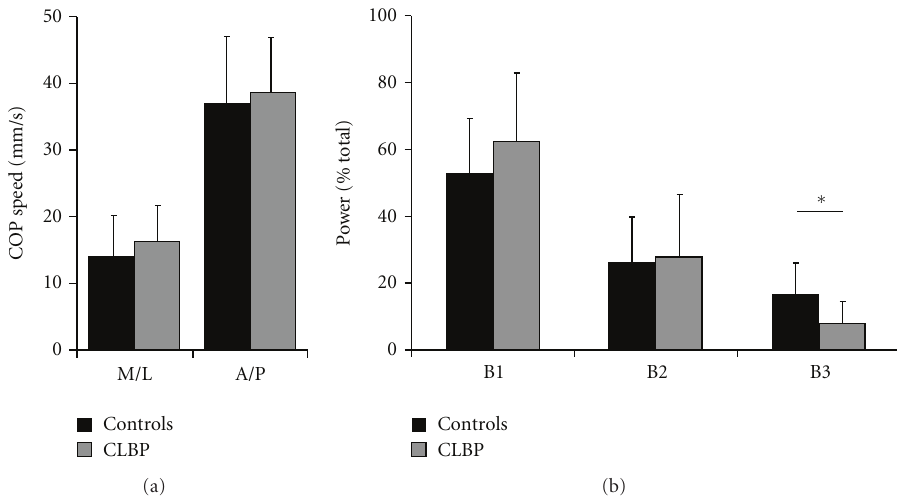
Figure 1: Comparison of postural steadiness between older CLBP women (grey) and controls (black). (a) Center of pressure (COP), speed in anteroposterior (A/P), and mediolateral (M/L) directions; (b) Power frequency bands (B1 to B3) for each group, expressed as a percentage of total power of COP signals. Data are mean ± SD; ∗ P < 0 . 05.